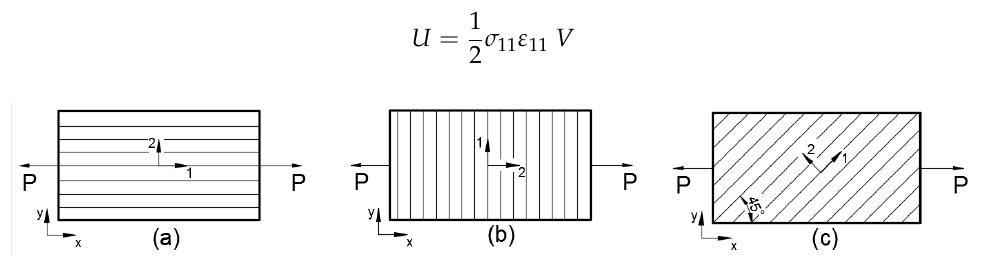
Figure 2. Uniaxial tensile loading of laminate with fiber oriented ( a ) along axis of loading; ( b ) normal to axis of loading and ( c ) off axis to axis of loading.